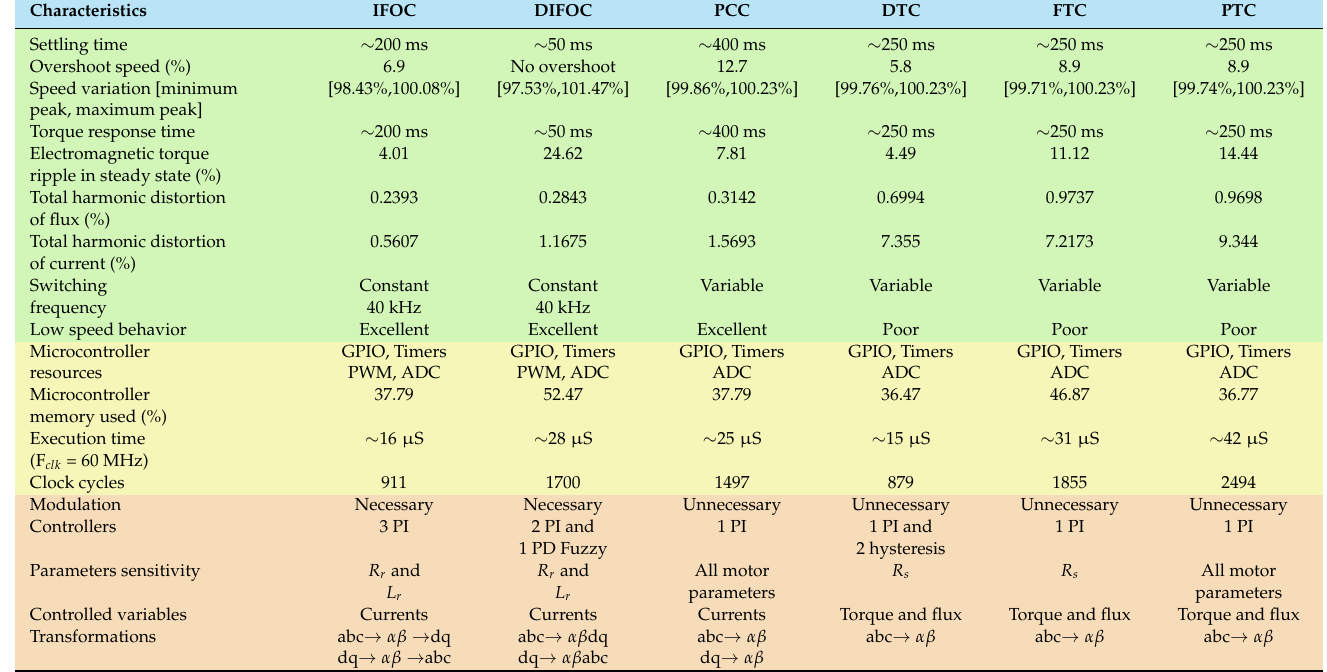
Table 1. Comparative table of developed controllers at T l = 10 Nm and speed of 1000 RPM. The dynamic performance, hardware resources and general characteristics are indicated with the colors green, light yellow and light orange, respectively.